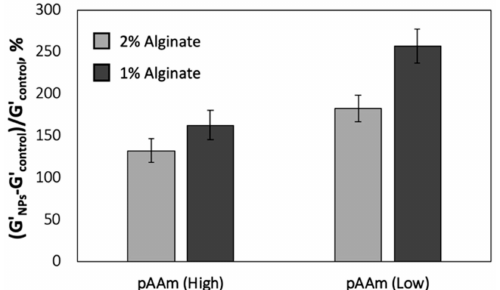
Figure 4. Relative elastic moduli of pAAM-alginate hydrogel nanocomposites, prepared using 5% (High) or 2.5% (Low) pAAm, 2% (light grey bars) or 1% (dark grey bars) alginate, and 2% 4 nm SiNPs. Values for relative elastic modulus were calculated by normalizing the values for the